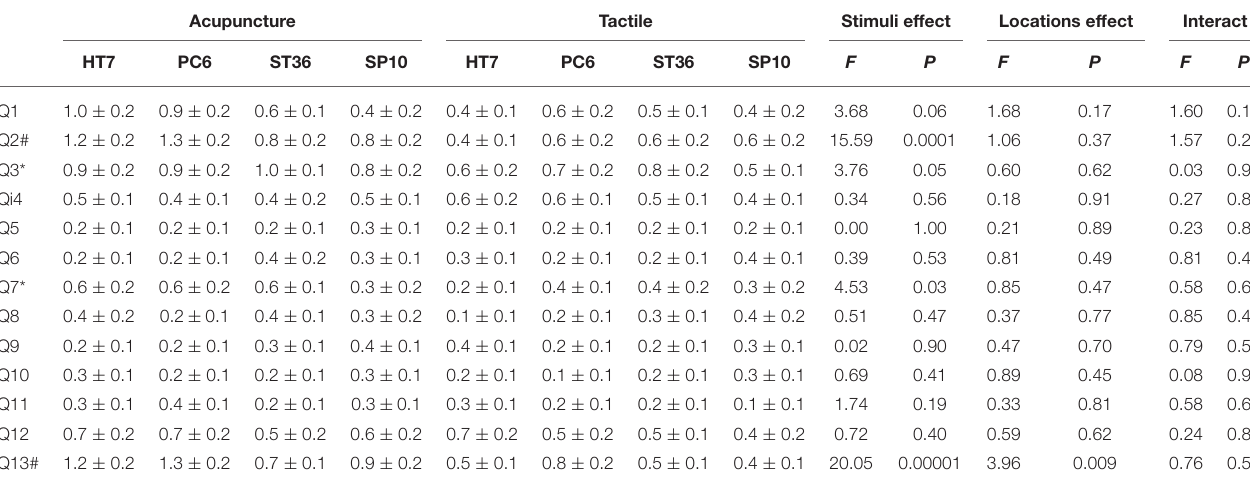
TABLE 1 | Psychophysical responses to DeQi sensations. Acupuncture Tactile Stimuli